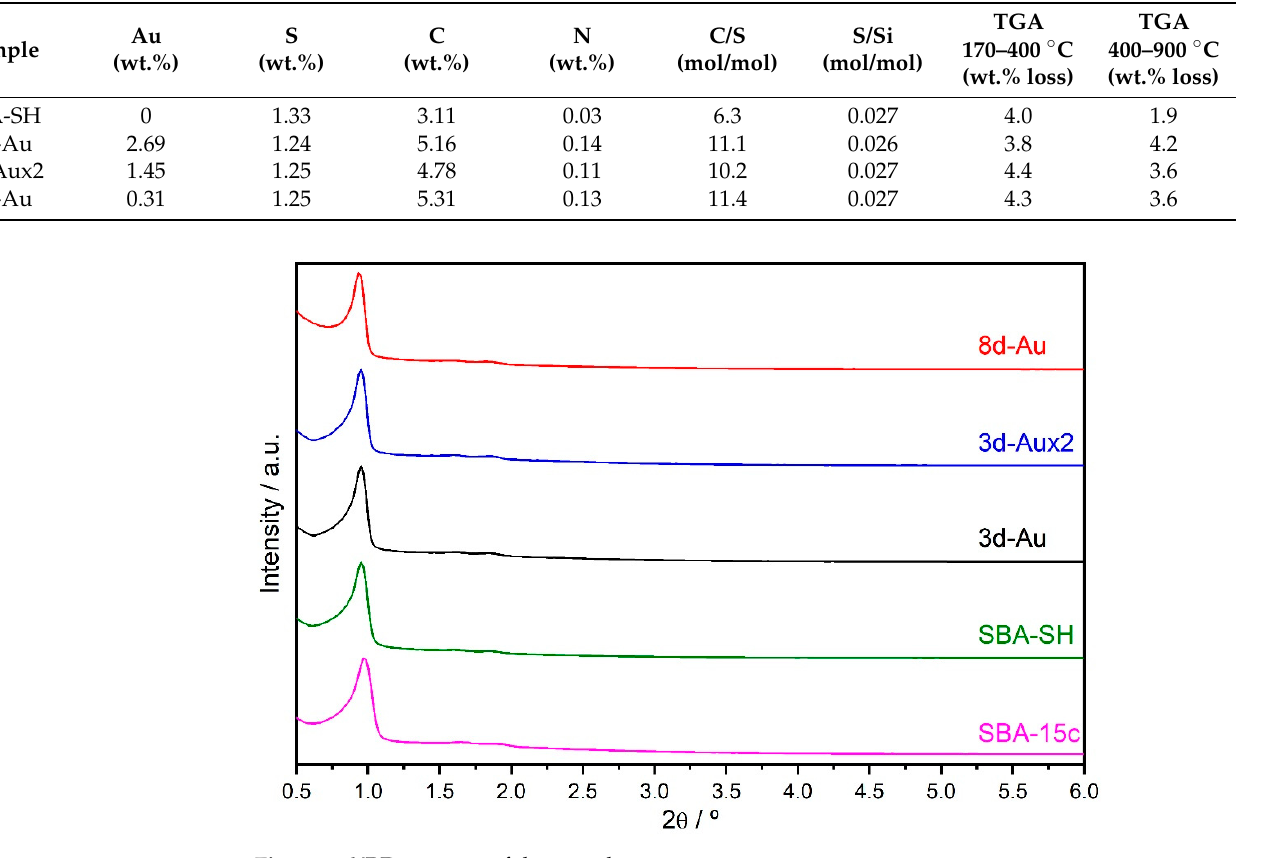
Figure 2. XRD patterns of the samples. Table 2. Structural and textural properties of the samples.